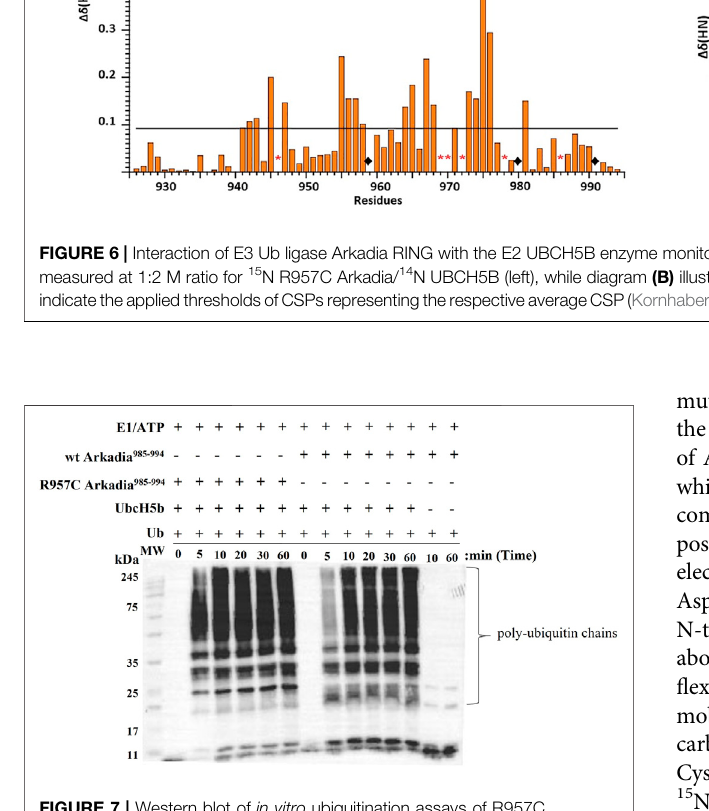
Frontiers in Molecular Biosciences |